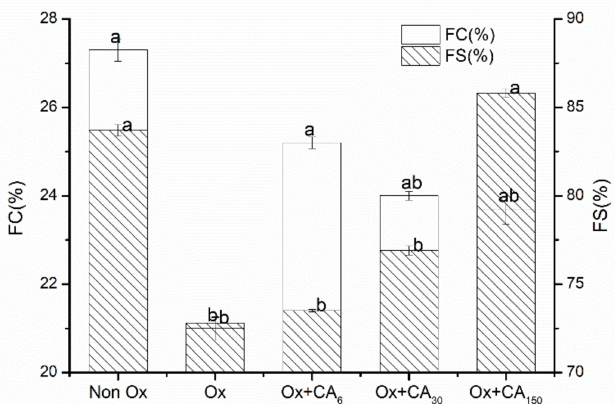
Figure 5. Changes in foaming capacity (FC) and foaming stability (FS) of oxidized myofibrillar protein (MP) treated with chlorogenic acid. Control: nonoxidized; Ox: oxidized; Ox + CA 6 , Ox + CA 30 , and Ox + CA 150 : oxidized in the presence of CA at 6, 30, and 150 µ M / g protein, respectively. Di ff erent lowercase letters denote significant di ff erences (p <